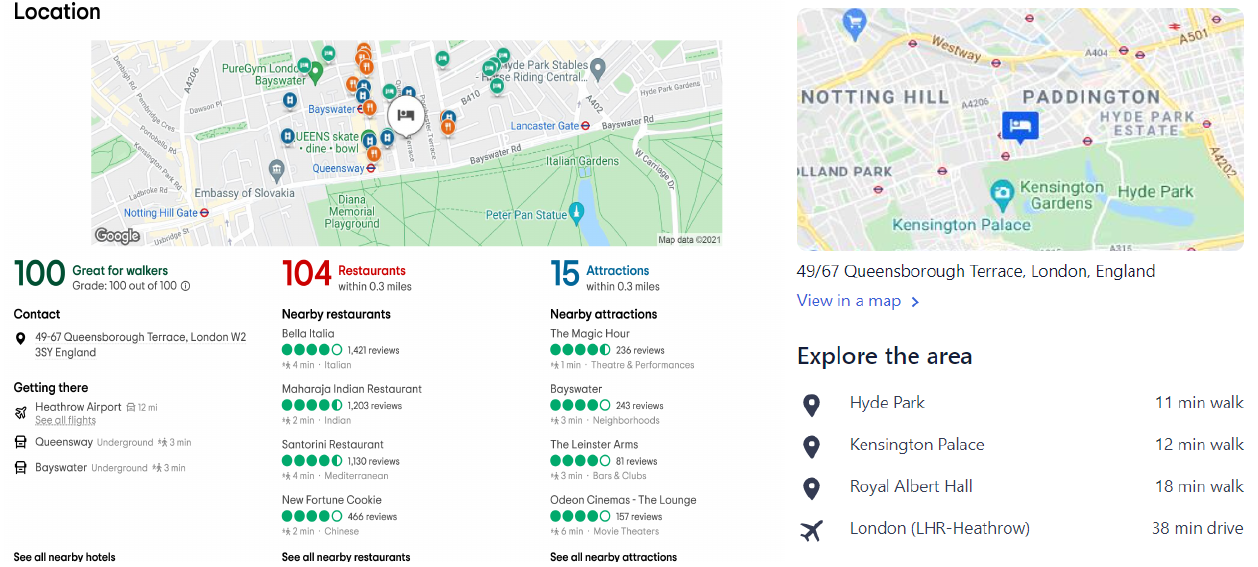
Figure 2. The surrounding facilities of the nearby areas of a specific hotel for two different hotel booking websites, i.e., TripAdvisor.com (accessed on 29 June 2021) and Expedia.com (accessed on 29 June 2021), respectively (Image Source: